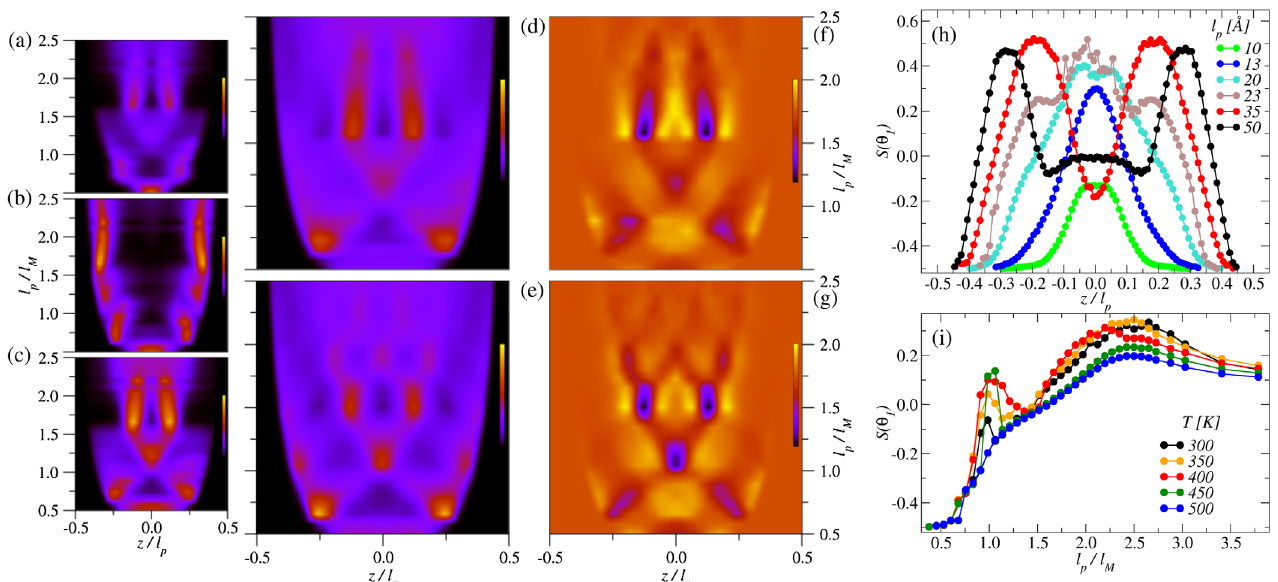
FIG. 2. Layering and orientational order. (a) – (c) Probability to find a bead associated to the polar and apolar parts of the cations and of the anions, respectively, at T ¼ 400 K. The data are shown as a function of the position in the pore normalized to the pore size, z=l =l all values of l , and are renormalized in [0, 1] (see color box). (d),(e) Total mass distributions at T ¼ 400 and 300 K, respectively, p M normalized in [0, 1]. (f),(g) Charge distributions at the same temperatures, normalized in the range ½ − 0 . 5 ; 0 . 5 (cid:2) . (h) z dependence of of the nematic order parameter S ð θ 1 Þ at T ¼ 400 K at the indicated values of l indicated values of T